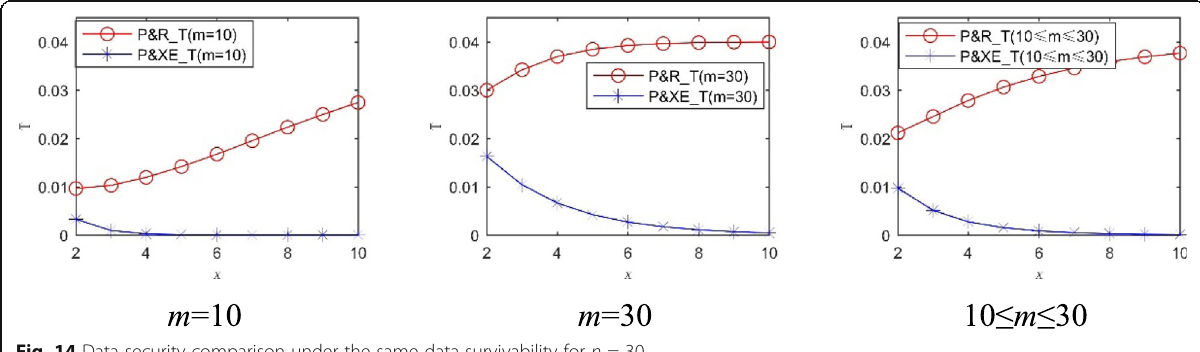
Fig. 14 Data security comparison under the same data survivability for n = 30